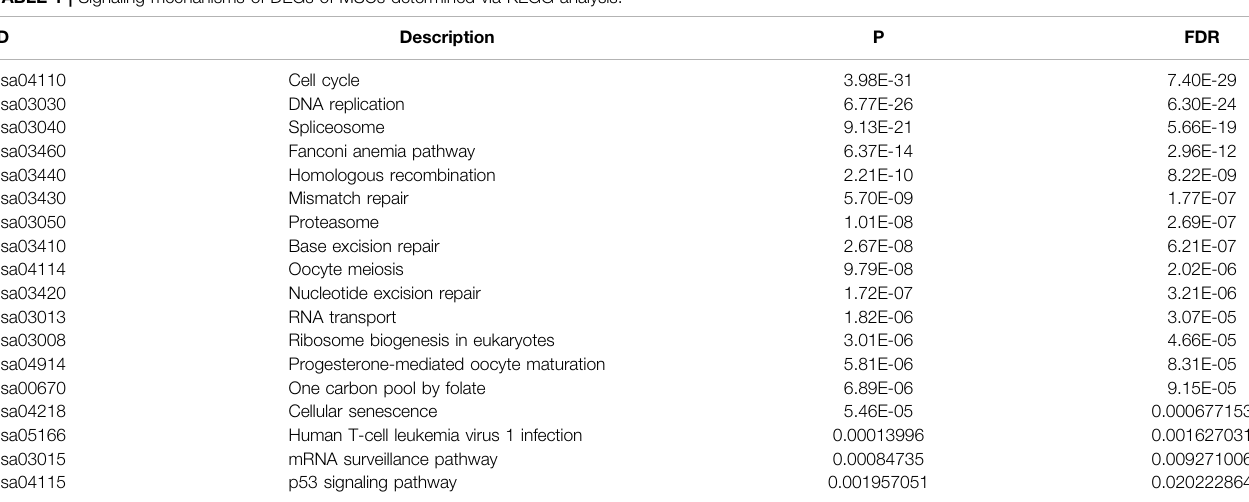
TABLE 1 | Signaling mechanisms of DEGs of MSCs determined via KEGG